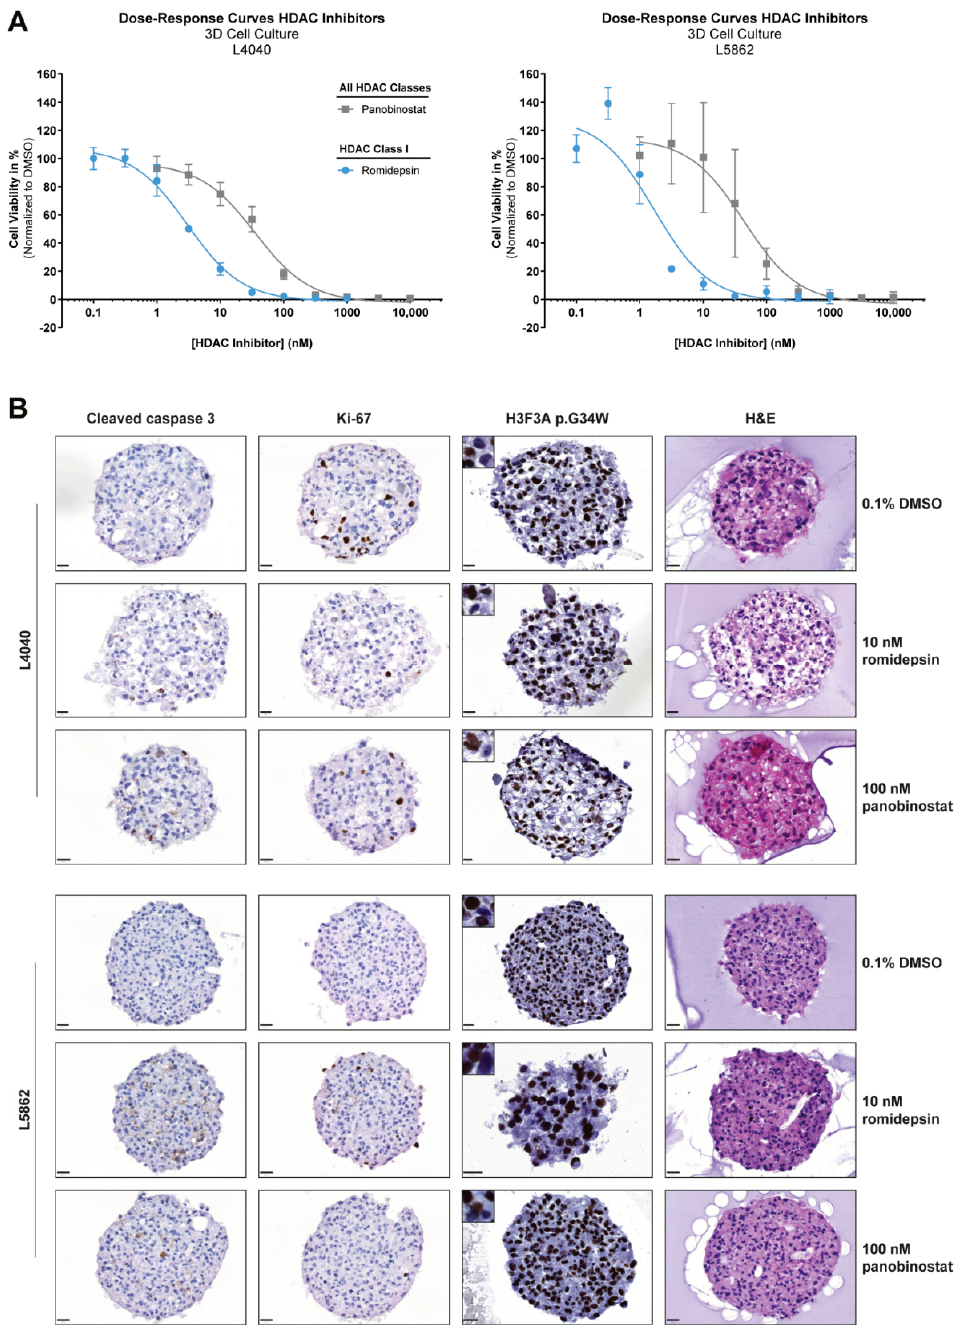
Figure 5. HDAC inhibitors reduce growth and induce apoptosis in 3D in vitro models of neoplastic “stromal” cells. ( A ) Dose–response curves of two HDAC inhibitors (i.e., panobinostat and romidepsin) after 72 h of treatment for cell lines cultured in 3D. Data points represent the mean of three experiments performed in triplicate ± standard deviation. HDAC inhibitor sensitivity was comparable between 2D and 3D in vitro models (Table 1). ( B ) H&E, H3F3A p.G34W, Ki-67, and cleaved caspase 3 stains on sections of L4040 and L5862 MCTS after 72 h treatment with 0.1% DMSO, 10 nM romidepsin, and 100 nM panobinostat. Images of single MCTS are representative of technical and biological triplicates. Both HDAC inhibitors induced apoptosis (increased cleaved caspase 3 levels) in L4040 and L5862 MCTS as compared with the 0.1% DMSO-treated controls. A reduction in proliferation (reduced Ki-67 levels) after HDAC inhibitor treatment was only observed in L4040 MCTS. Scale bar: 20 µ